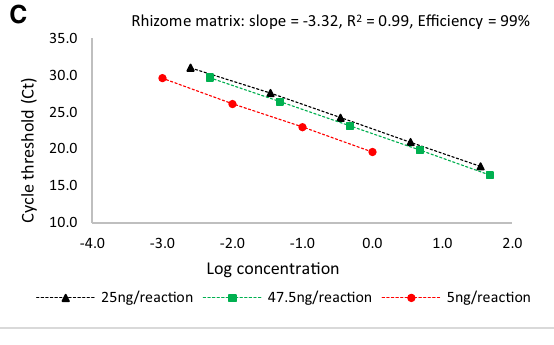
Powder matrix: slope = -3.3, R 2 = 1.00, Efficiency = 100%